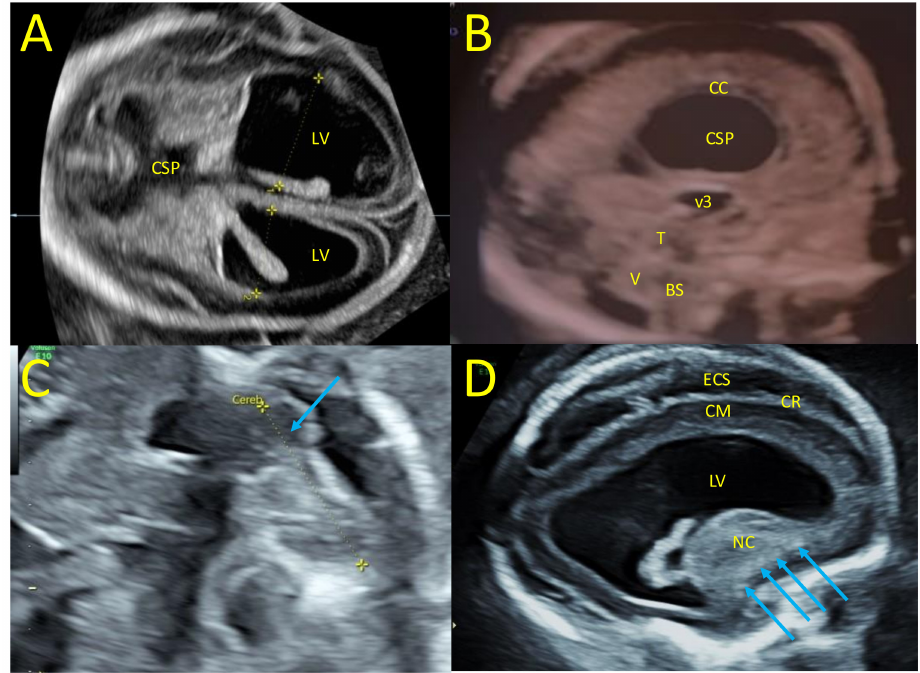
Figure 1. Fetal neurosonography at 22 wg. ( A ) Trans-ventricular axial plane with severe bilateral ventriculomegaly, lateral ventricles (LV) at 23 mm and 17 mm, and disruption of the cavum septi pellucidi (CSP). ( B ) Mid-sagittal plane with laminated corpus callosum (CC), dilated third ventricle (3 V), thick tectum (T), hypoplasia of the vermis (V), and brainstem (BS). ( C ) Trans-cerebellar axial plane with dysplasia of a cerebellar hemisphere (blue arrow). ( D ) Para-sagittal plane with enlarged LV, periventricular hyperechogenicity, thin cortical mantle (CM), irregular cortical ribbon (CR), enlarged peri cerebral spaces, dysmorphic nuclei caudate with calcifications (blue